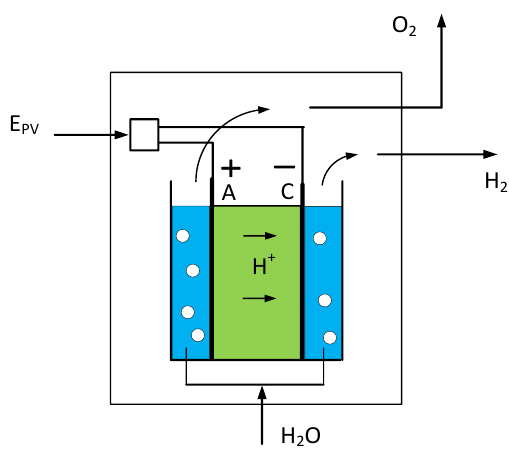
Figure 2. Hydrogen production from water electrolysis .